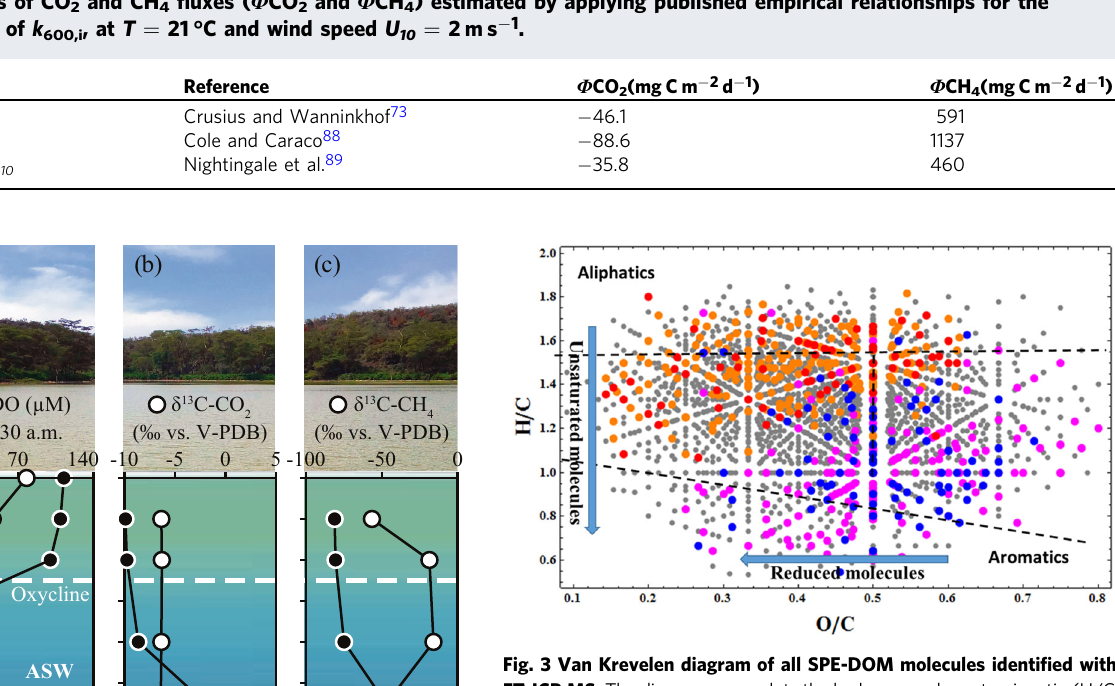
(Table 1). The δ 13 C-CH 4 values ranged from − 78 in BW to − 16 in SW ‰ vs. V-PDB (Fig. 2).